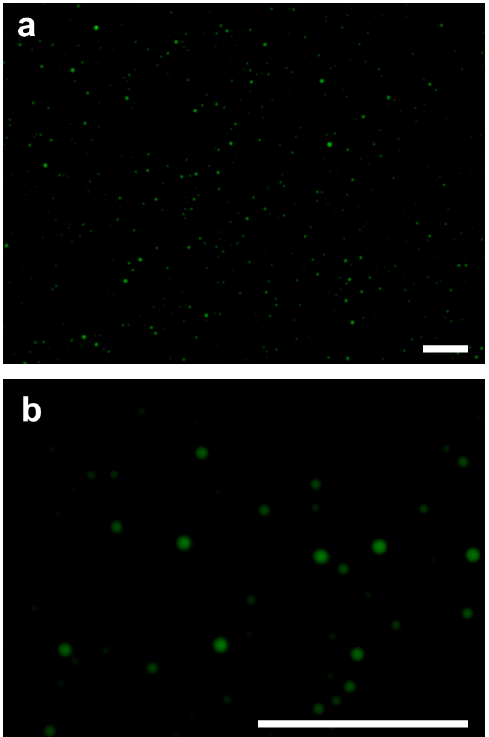
Figure 1. Shh coacervate imaging. Alexa Fluor 488-labeled Shh was incorporated into the coacervate in water and imaged by fluorescence microscopy. ( a ) 10 6 magnification. ( b ) 40 6 magnification. Scale bars=100 m m.